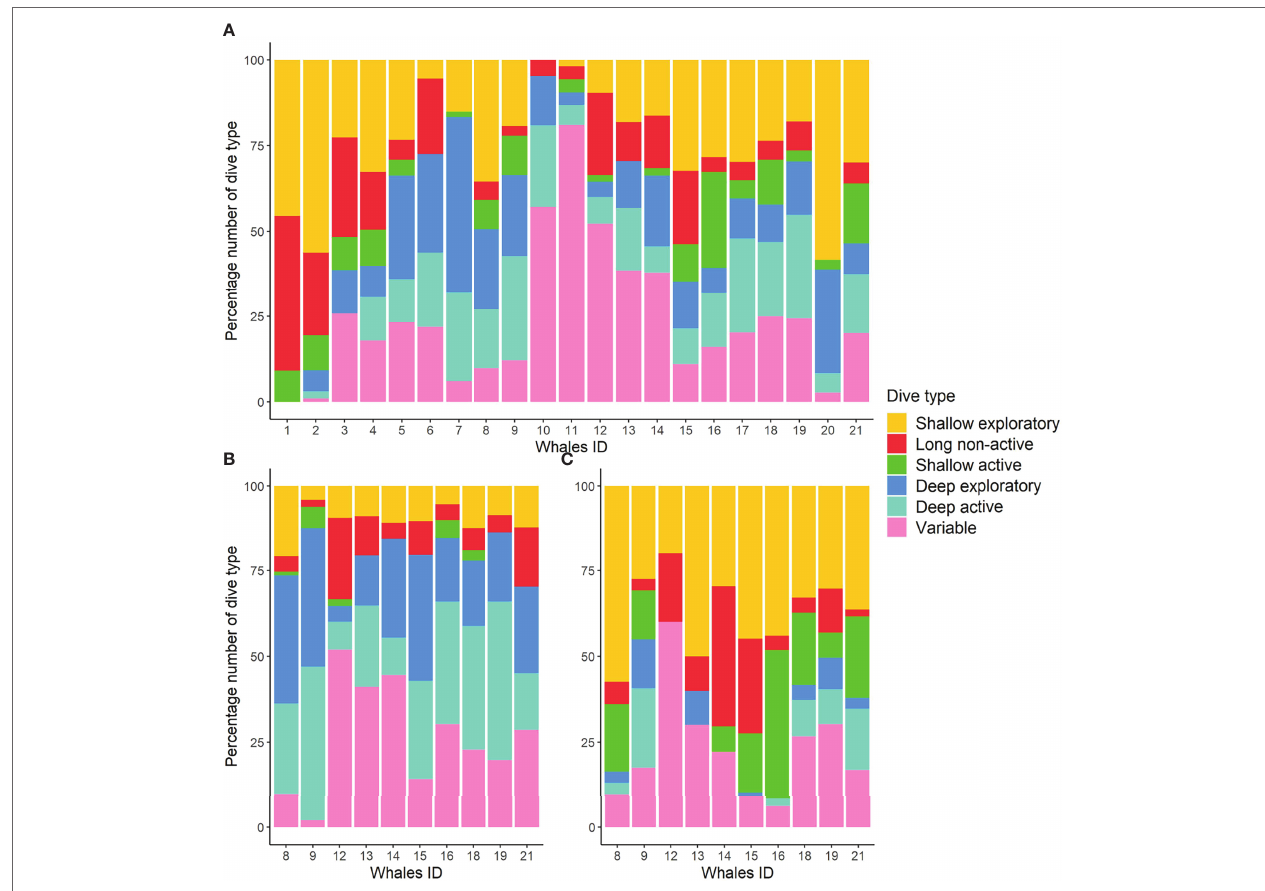
FIGURE 4 | Percentage number of each dive type (shown with different colors) by individual for 21 fin whales tagged in this study (A) . Percentage number of each dive type during the day (B) and night (C) for 10 fin whales with tag attachments longer than 15